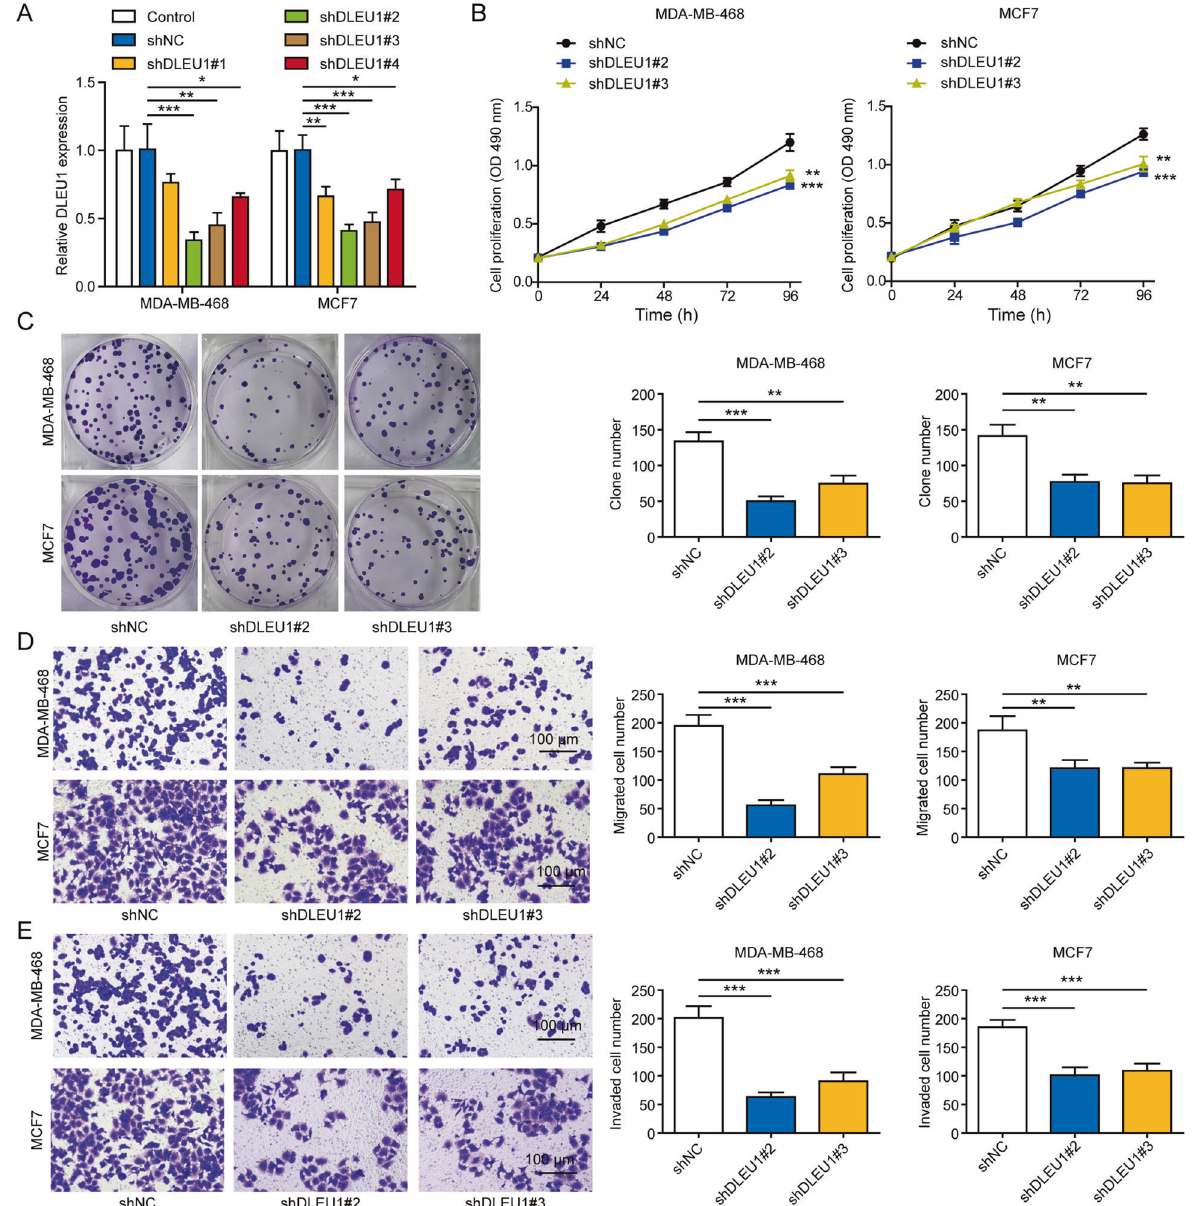
Fig. 2 DLEU1 essentially controls various malignant behaviors of breast cancer cells. MDA-MB-468 and MCF7 cells were either not transfected (control), or stably transfected with shNC, shDLEU1#1, #2, #3, or #4. A DLEU1 level was examined by RT-PCR. B The proliferation of shNC, shDLEU1#2, or shDLEU1#3 cells was examined by MTT assay. C Cell proliferation was examined by colony formation assay (left), with the quanti fi cation of colony numbers on the right. The migration ( D ) and the invasion ( E ) of indicated cells were examined by Transwell assays (left), with the number of migrated/invaded cells presented on the right. * P < 0.05, ** P < 0.01, *** P <